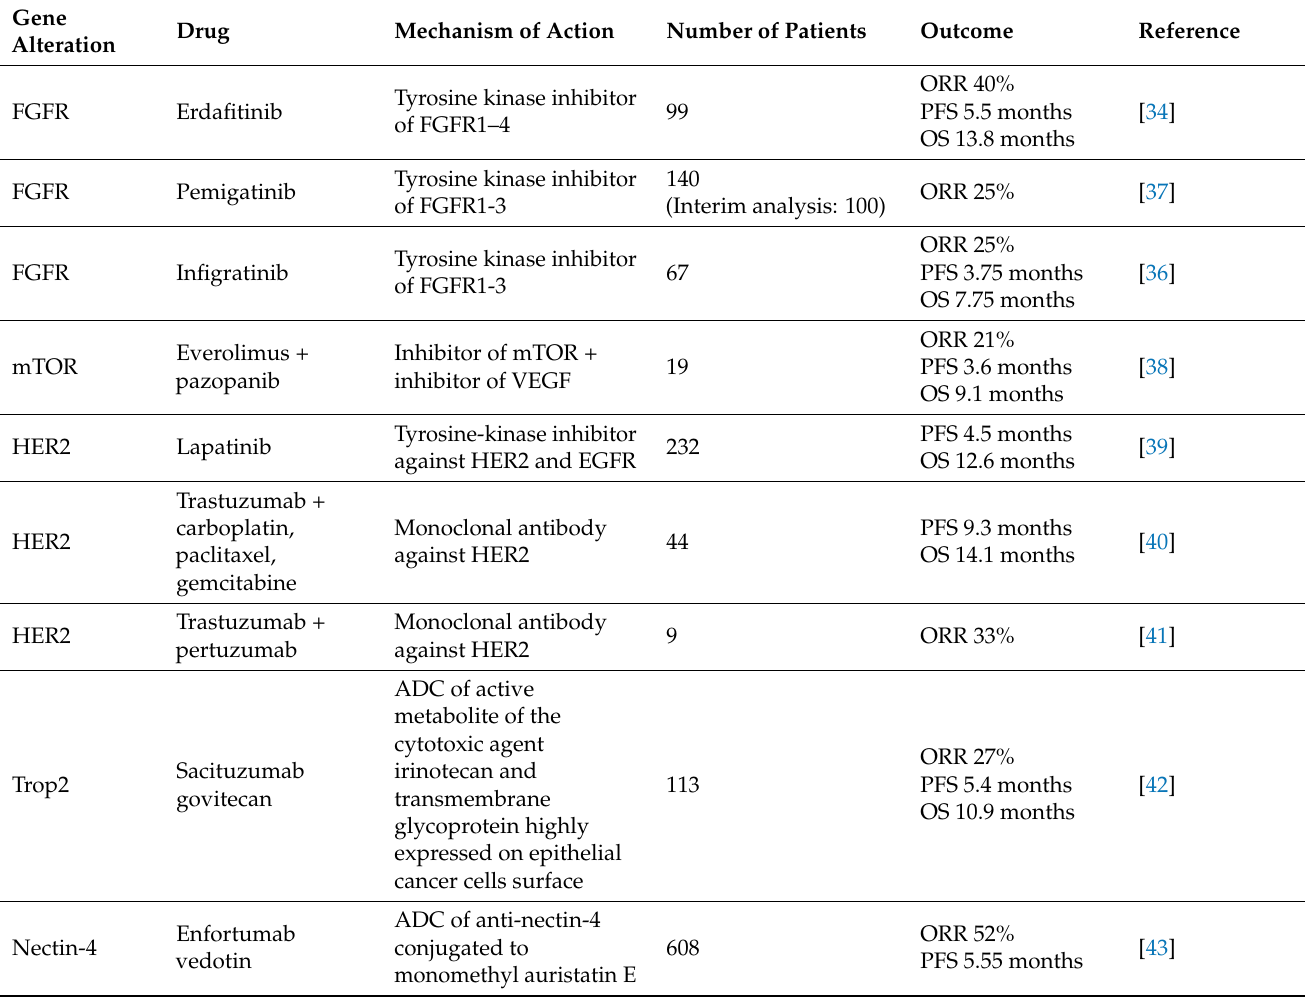
Table 1. Targeted therapies and